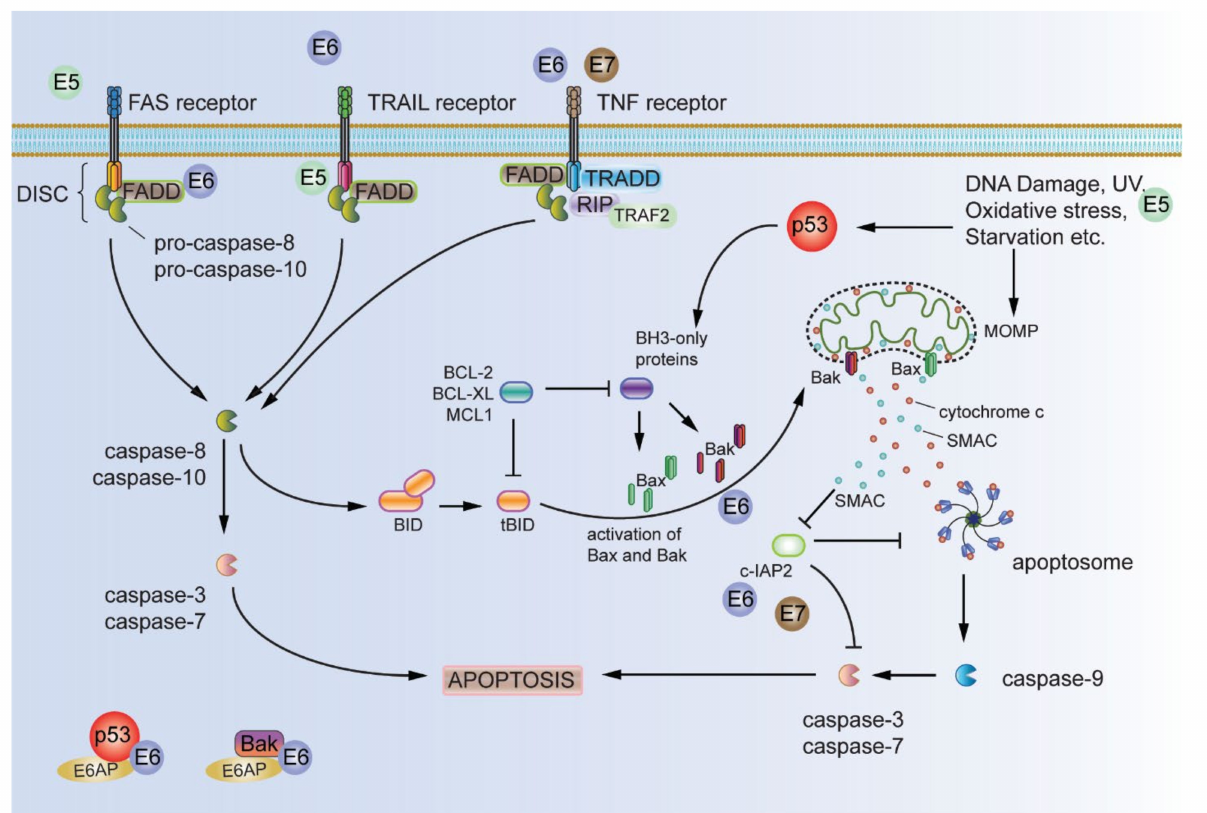
Figure 5. Resisting cell death. One of the major roles played by HPV oncoproteins in resisting cell death is evading apoptosis. Both extrinsic and intrinsic apoptotic pathways are deregulated to attain this function by HPV-E5, -E6 and -E7. The extrinsic apoptotic pathway is activated upon receptor trimerization and the subsequent recruitment of adaptor molecules and procaspase 8 to the DISC. The activation of caspase 8 then leads to the activation of downstream executioner caspases 3 and 7, leading to cell death/apoptosis. The intrinsic apoptotic pathway is activated by external stimuli (UV-radiation, oxidative stress, DNA damage, starvation, etc.), leading to the formation of pores in the mitochondrial membrane and release of mitochondrial inner membrane proteins (cytochrome c, SMAC) into the cytosol. Released cytochrome c and pro-caspase 9 form the apoptosome, leading to activating caspase 9, which, in turn, activates downstream executioner caspases 3 and 7, leading to apoptosis. E5 can downregulate the Fas receptor and perturb the formation of the DISC complex, thus abrogating the extrinsic apoptotic pathway. Further, E5 can perturb ROS-induced Bax activation and inhibit the apoptotic response to UV B radiation. E6 can block extrinsic pathways by binding the death domain, leading to its proteasomal degradation. E6 inactivates p53, Bax and Bak, thus abrogating MOMP and the release of cytochrome c and, thus, inhibiting the intrinsic apoptotic pathway. E6 can also inhibit antiapoptotic c-IAP2, blocking the formation of the apoptosome and activation of the executioner caspases. E7 seems to have a dual function in activating and abrogating apoptosis; however, E7 has been demonstrated to perturb TNF receptor-induced apoptosis by upregulating c-IAP2 and suppressing caspase 8. FADD—Fas-associated protein with death domain, TNF—tumour necrosis factor, TRAIL—FasL and TNF-related apoptosis-inducing ligand, TRAF2—TNF receptor-associated factor 2, DISC—death-induced signalling complex, c-IAP2—cellular inhibitor of apoptosis protein 2, RIP—receptor interacting protein and MOMP—mitochondrial outer membrane